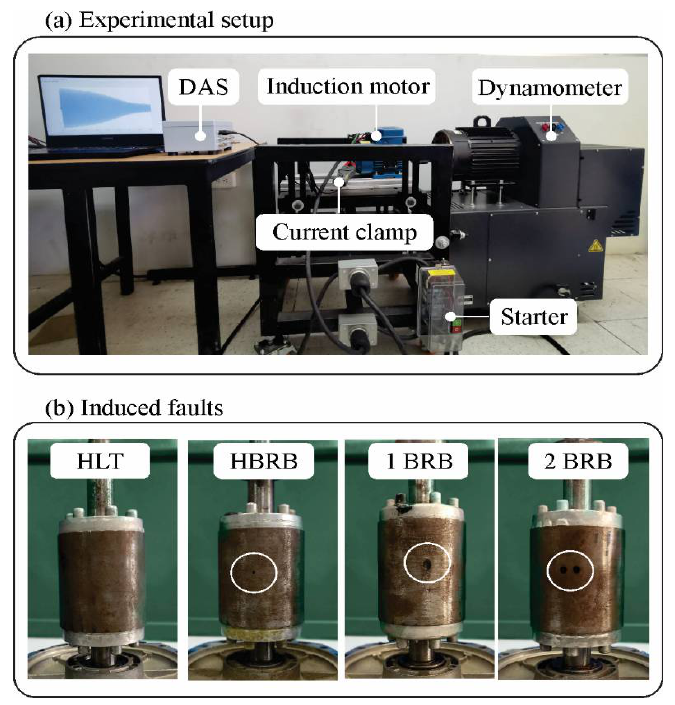
Figure 4. ( a ) Experimental setup and ( b ) rotor